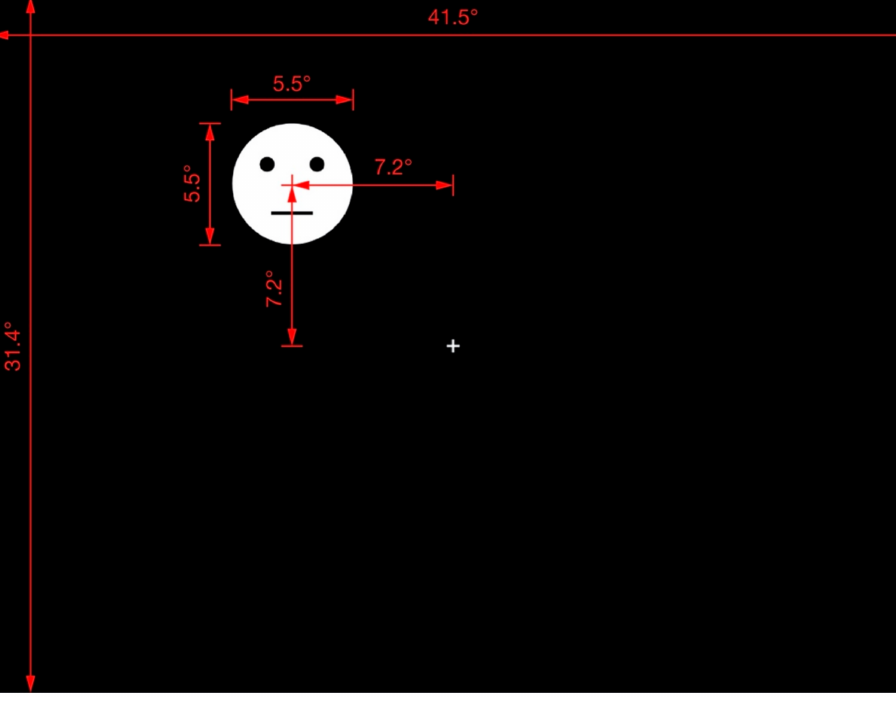
Figure 2. Display of test stimulus. Red lines, marks, and numbers were not presented in the actual experimental display. This is an example of the test stimulus appearing in quadrant II. The test stimulus and priming line could appear in any quadrant at the same distance from the center of the display.